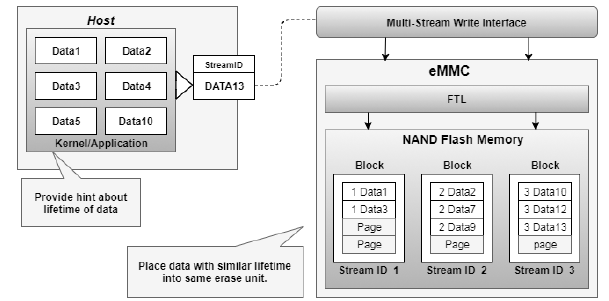
Figure 4. Mapping Data with same lifetime to corresponding stream-id